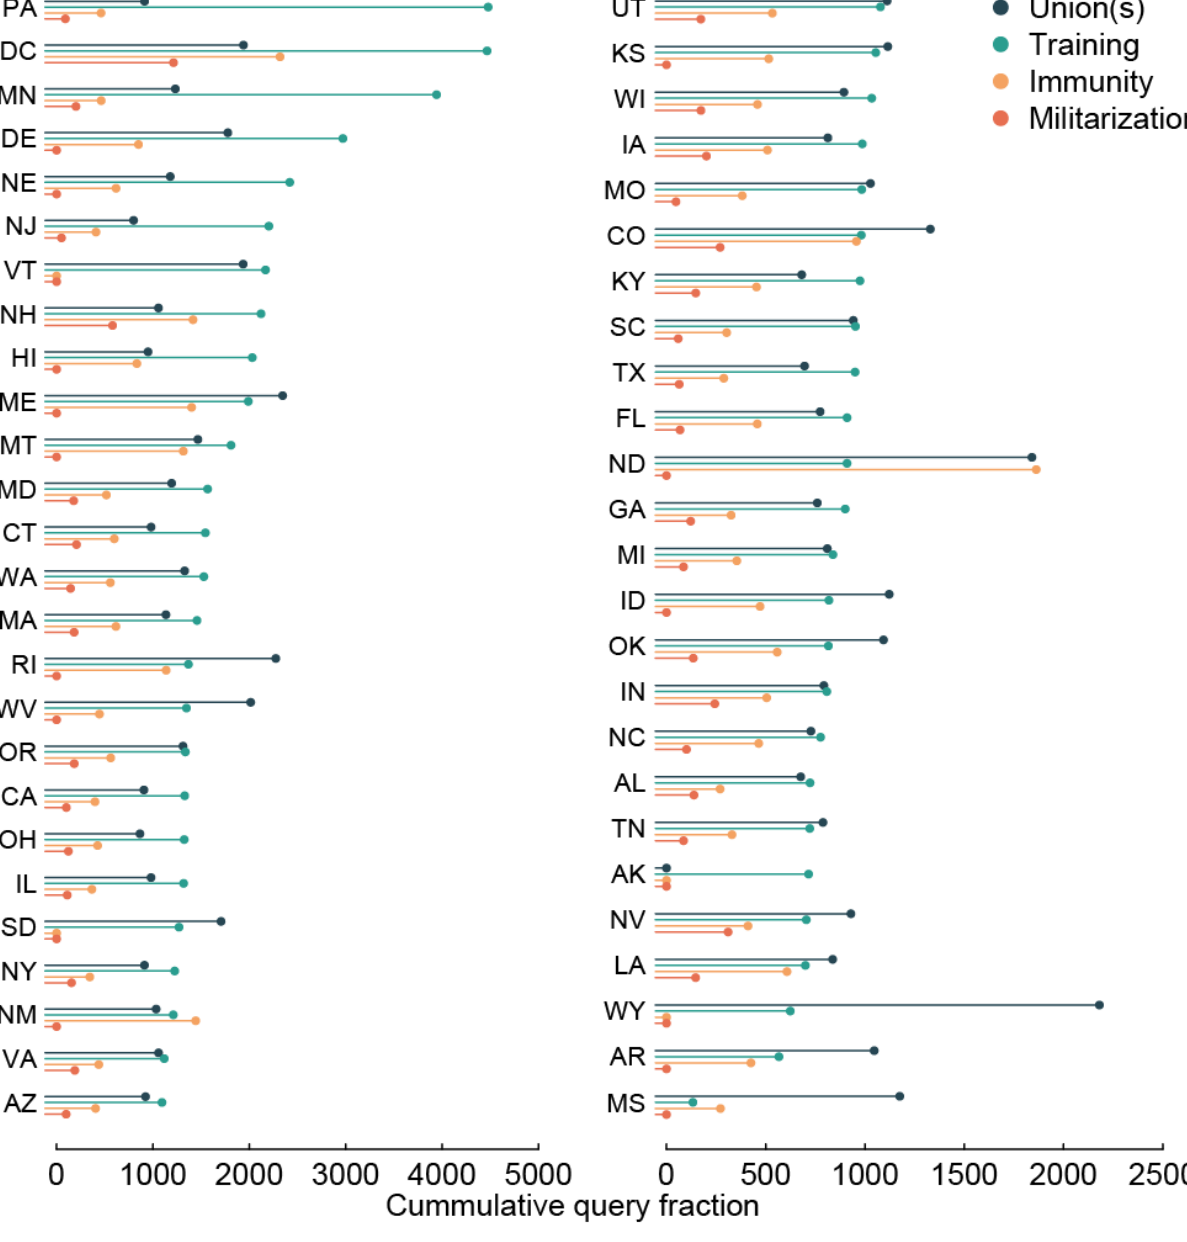
Figure 3. Internet searches for specific police reforms following the death of George Floyd, by US state (including Washington DC). Queries included all searches with the terms “police” and (A) “immunity,” (B) “union(s),” (C) “training,” or (D) “militarization.” The value presented is the cumulative query fraction of searches for the focal terms relative to all searches per 10 million for the period after Mr Floyd’s death (May 25, 2020, through July 5, 2020). States are ordered by cumulative query fraction for